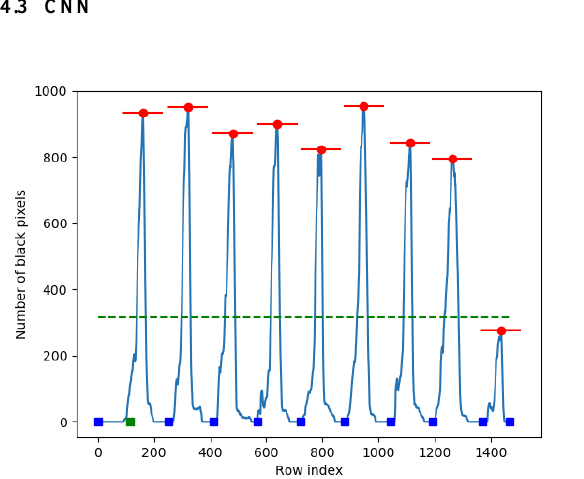
Figure 4. Horizontal histogram of a handwritten image from the CVL dataset